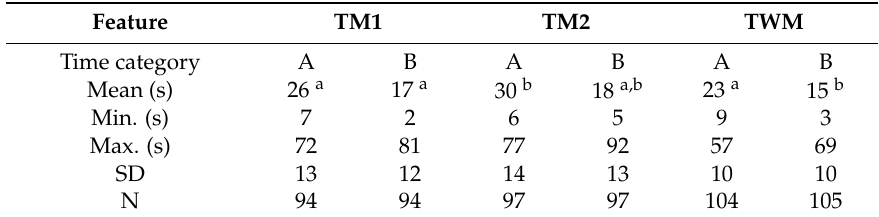
Table 7. Harvester time consumption per one tree; results of Mann-Whitney U test and descriptive statistics of time